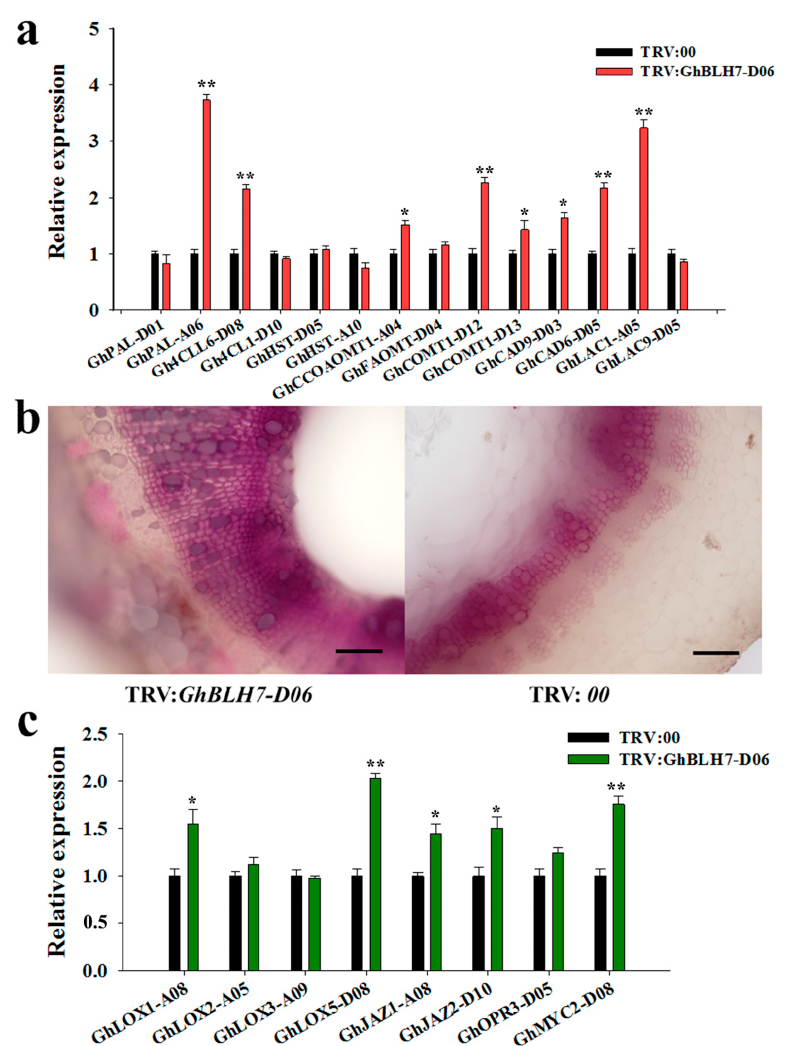
Figure 4. Observation and detection of lignin components in GhBLH7-D06 -silenced plants and control plants: ( a ) expression analysis of lignin synthesis-related genes in GhBLH7-D06 -silenced plants and control plants; ( b ) observation of lignin phloroglucinol staining sections of GhBLH7-D06 -silenced plants and control plants (scale bars = 0.1mm); and ( c ) expression analysis of JA signaling pathway genes in GhBLH7-D06 -silenced plants and control plants. Error bars represent the standard deviation of three biological replicates. Asterisks indicate statistically significant differences, as determined by Student’s t -test (* p < 0.05; ** p < 0.01).